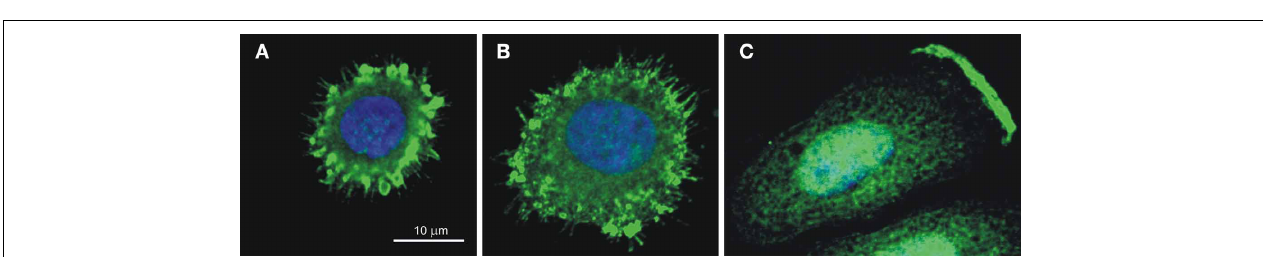
FIGURE 4 | The functional contribution of CA IX to the cancer-related phenomena affected by acidosis in tumor microenvironment. CA IX appears to be involved in many aspects of tumor progression as supported by the experimental evidence in preclinical models as well as by the clinical data from tumor tissue specimens. CA IX induces changes in activities and/or levels of kinases, ion transporters and other regulatory molecules and its expression correlates with certain cancer markers (Giatromanolaki et al., 2001; Bartosova et al., 2002; Swinson et al., 2004; Dorai et al., 2005; Skrzypski et al., 2008; Shin et al., 2011; Csaderova et al., 2013; Radvak et al., 2013), CA IX protects tumor cells from hypoxia and acidosis and its expression correlates with poor disease-free survival (DFS), overall survival (OS) and markers of tumor hypoxia and metabolism (Beasley et al., 2001; Koukourakis et al., 2006a,b; Chiche et al., 2009; Rajaganeshan et al., 2009; Lou et al., 2011; Rademakers et al., 2011; McIntyre et al., 2012; Kim et al., 2013). Although its direct role in genomic instability and angiogenesis has not been analyzed (N.A.), CA IX modulates expression of EMC components